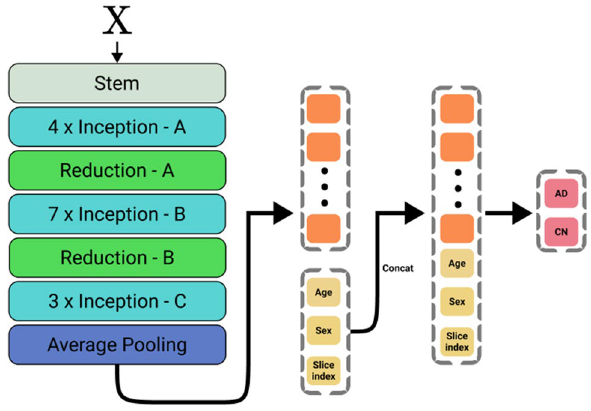
Figure 1. Diagram of the network architecture. For each participant, the model fed 1 out of 30 coronal slices individually. The results of the 30 slices were averaged to produce probability of diagnosing AD for that